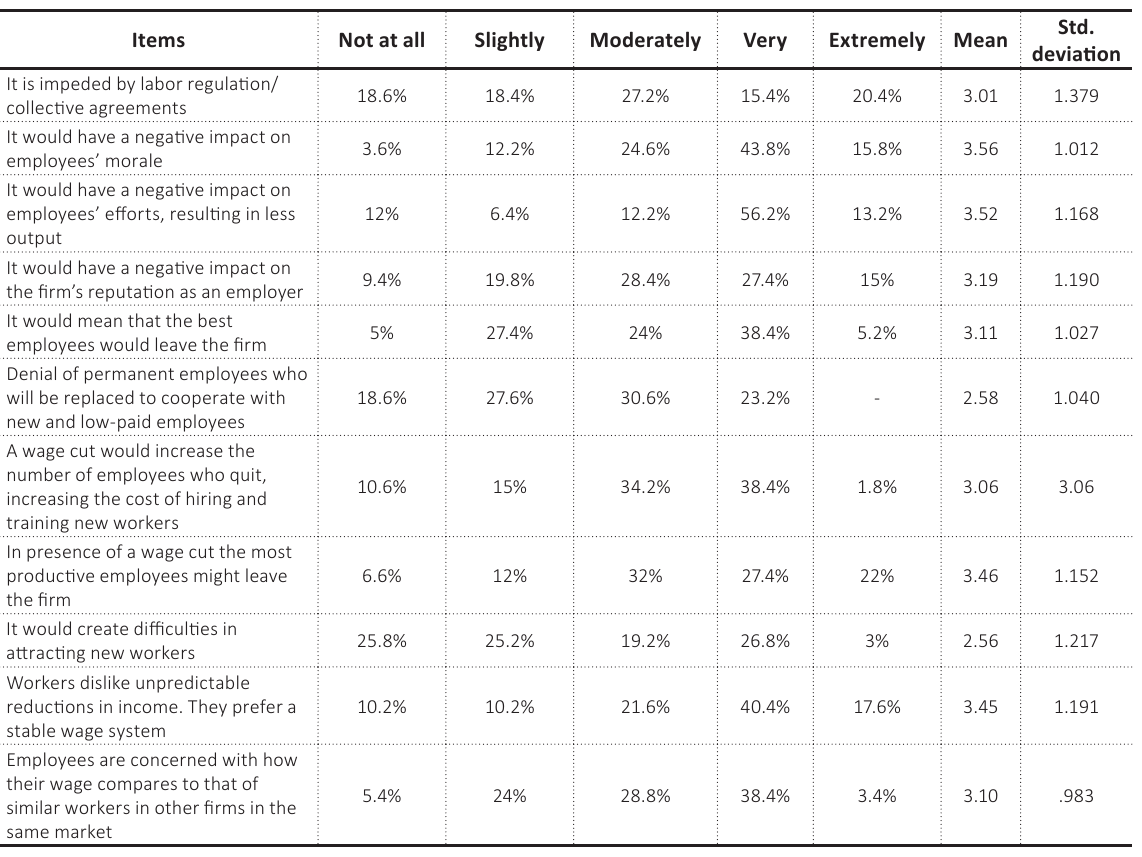
Table 2. Reasons that refrain firms from cutting wages to reduce labor